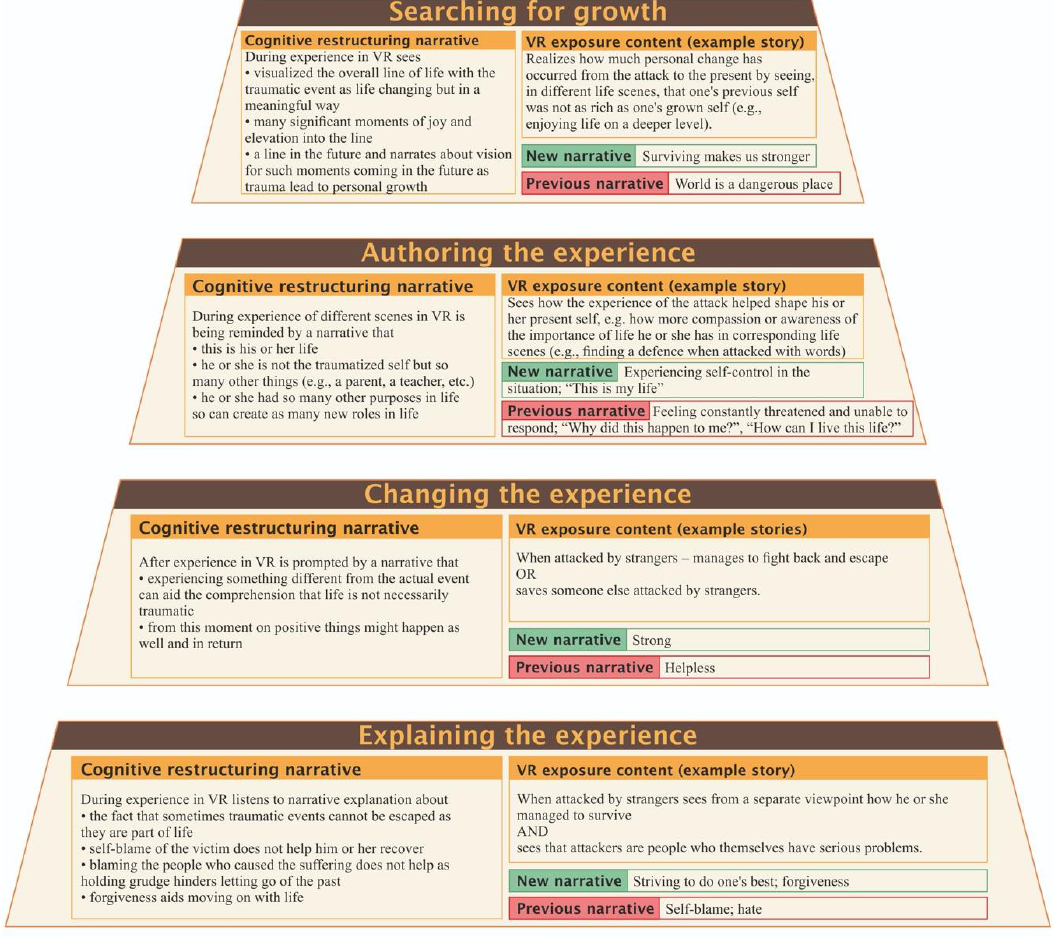
Figure 4. Procedure to reexperience one’s line of life under the guidance of a therapist in the case of physical assault.